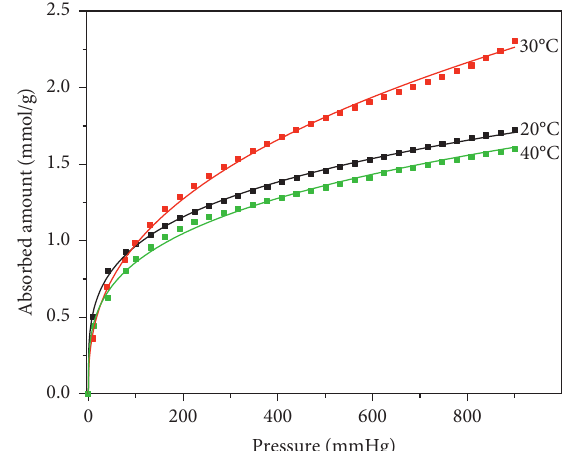
Figure 10: Carbon monoxide adsorption isotherms of 1CuCl/ diatomite at different temperatures.